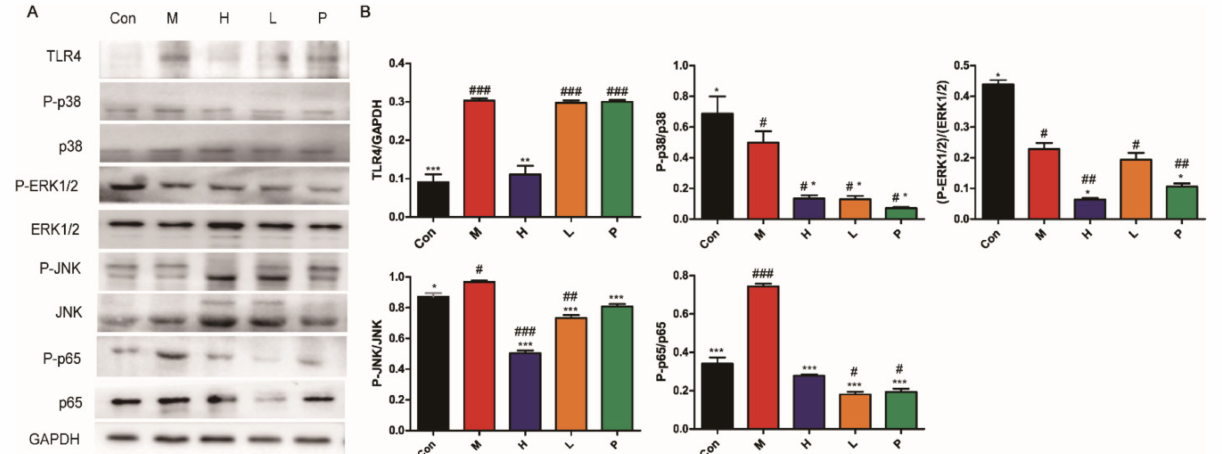
Figure 8. Inhibition of TLR4/MAPK/NF- κ B signaling pathway. ( A ) Expression of TLR4, phosphorylated p38 (P-p38), p38, P-ERK1/2, ERK1/2, P-JNK, JNK, P-p65, p65 was shown. ( B ) The analysis of grey scale value. Con was control group, M was model group, H was the high dose OPA group, L was low dose OPA group, P was positive group. Data were expressed as the mean ± SD, the statistical analyses were done with t -test; *** p < 0.001, ** p < 0.01, * p < 0.05 compared with the model group; ### p < 0.001, ## p < 0.01, # p < 0.05 compared with the control